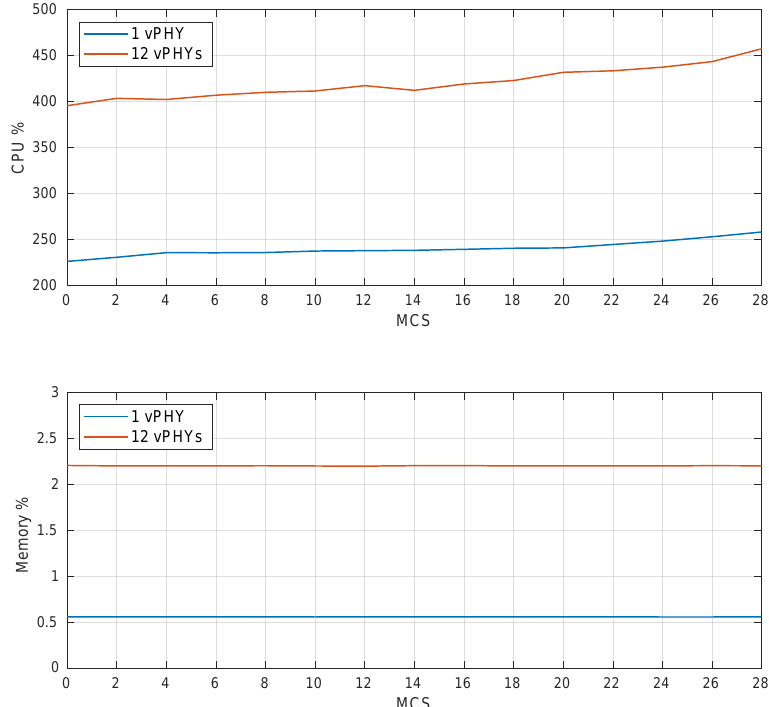
Figure 22. CPU and memory use of the architecture prototype for 1 and 12